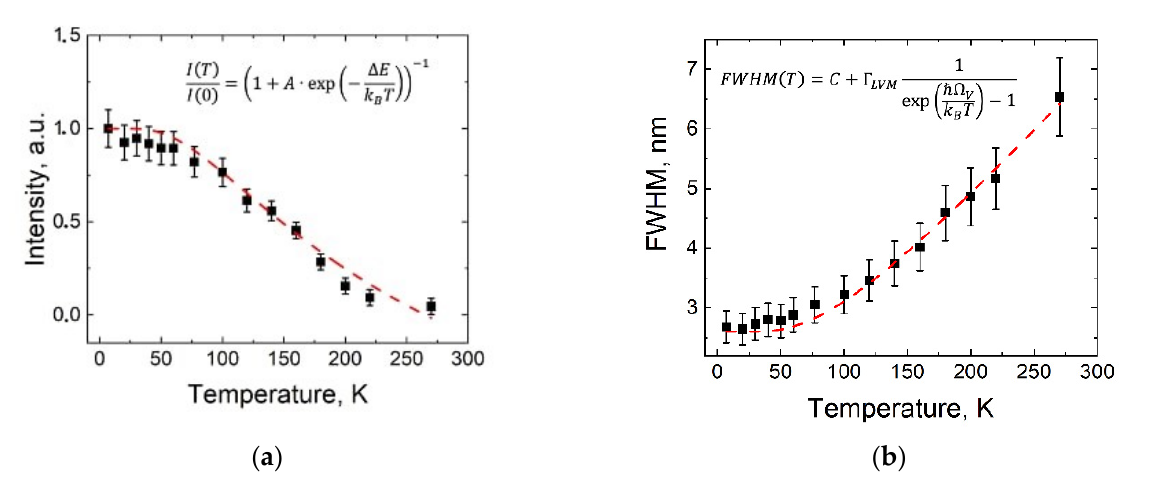
Figure 3. Temperature dependencies of the ZPL intensity and linewidth (FWHM) for the W complexes in HFCVD diamond nanoparticles. ( a ) ZPL intensity, ( b ) ZPL FWHM. Solid full squares represent the experimental data, the dashed lines are results of fitting with the least square method. Insets in the figures show the fitting formulas. The error bars are shown.